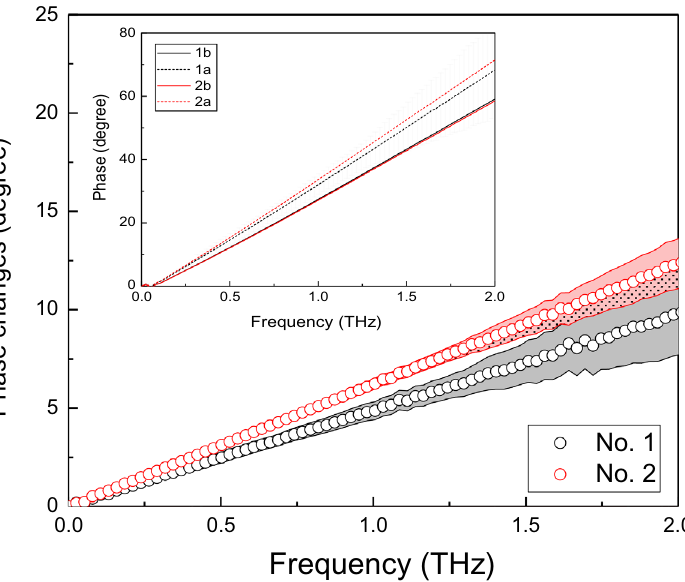
Figure 5. The phase difference versus frequency for corneal samples No 1. and No. 2, data with error bar indicated. Insert figure: Phase versus frequency for cornea No. 1 and No.2. 1a and 2a indicate the curves after the light stress, while the 1b and 2bindicate the curves before the light